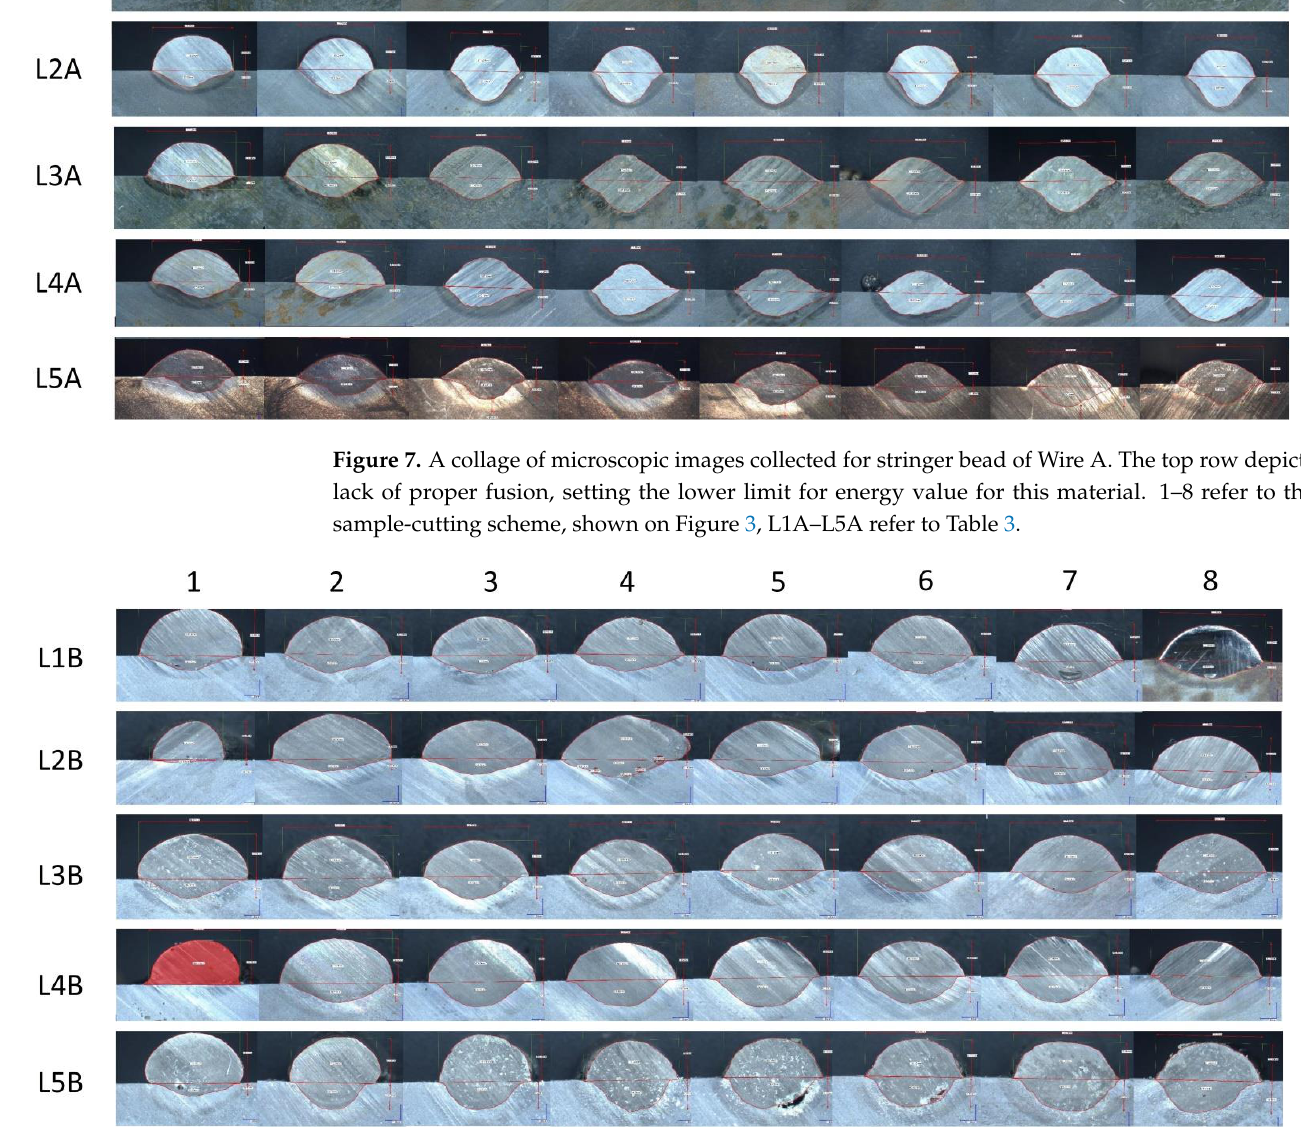
Figure 8. A collage of microscopic images collected for the stringer bead of Wire B. The bead fragment highlighted with red color marks the bead with welding defect (L4B, 1), namely incomplete fusion. 1–8 refer to the sample-cutting scheme, shown on Figure 3, L1B–L5B refer to Table 3. The quantitative data of the dimensional measurements is presented on Figures 9 and 10, where the values were averaged. The dimensional measurements of the cross-sections of the beads show that, despite the same input parameters, the two inspected materials behave thoroughly different. Wire A manifests low, but with observable variability, in the case of every studied dimension; additionally, a “sweet-spot” can be indicated at around 8000 mm/min. wire feed and 1000 mm/min. welding